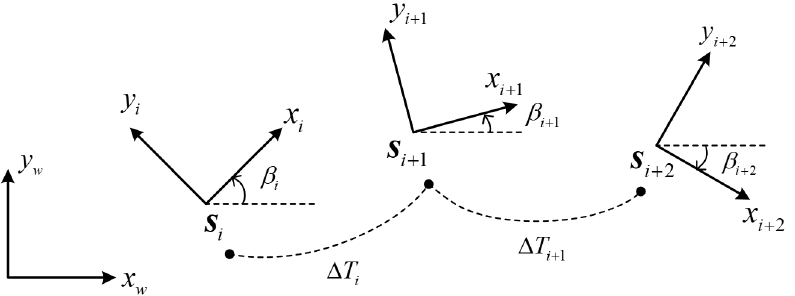
Figure 2. Illustration of the TEB algorithm. The TEB is a sequence of AGV poses forming a trajectory. Consecutive poses are tied to one another by a time